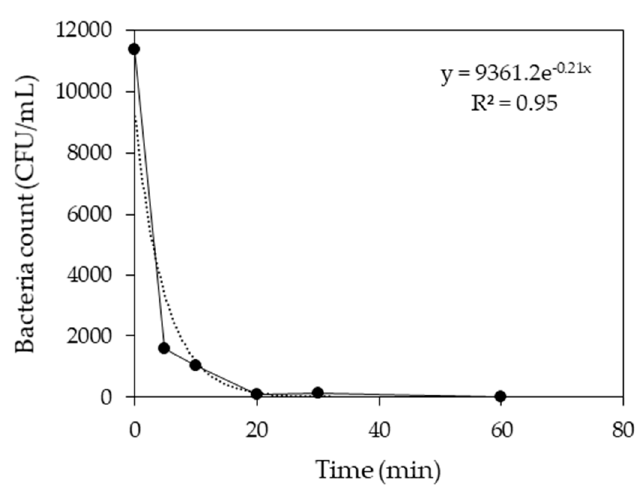
Figure 10. Microbial load analysis of e ffl uent after electrochemical treatment.